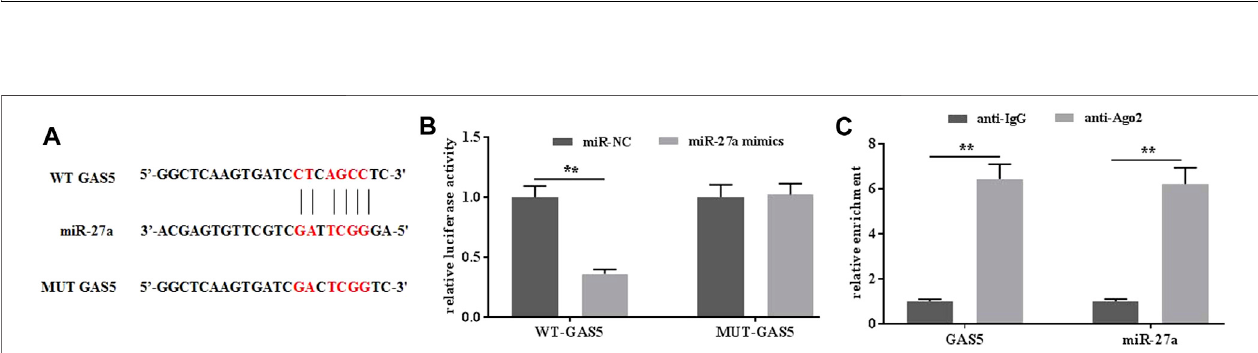
FIGURE 4 | GAS interacted with miR-27a. (A) The potential interaction between GAS5 and miR-27a was predicted by Starbase2.0 software. (B) The relative luciferaseactivitywasdeterminedinchondrocytesco-transfectedwithbothWT/MUT-GAS5andmiR-27amimics/miR-NC. (C) TheinteractionbetweenGAS5andmiR- 27a was con fi rmed by RIP assays. ** p < 0.01.